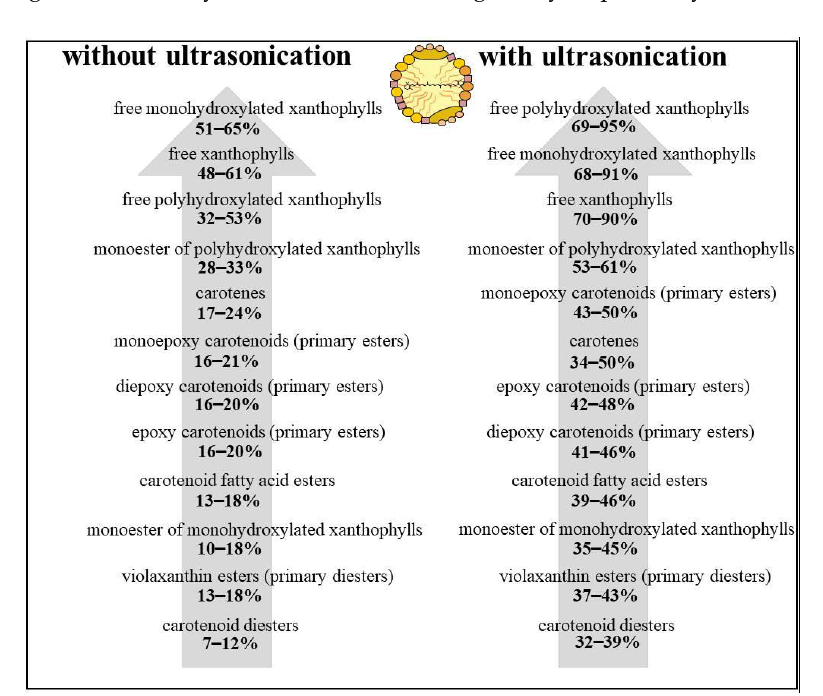
Figure 6. Micellarization efficiencies of several carotenoid groups in the orange juices without and with ultrasonication.